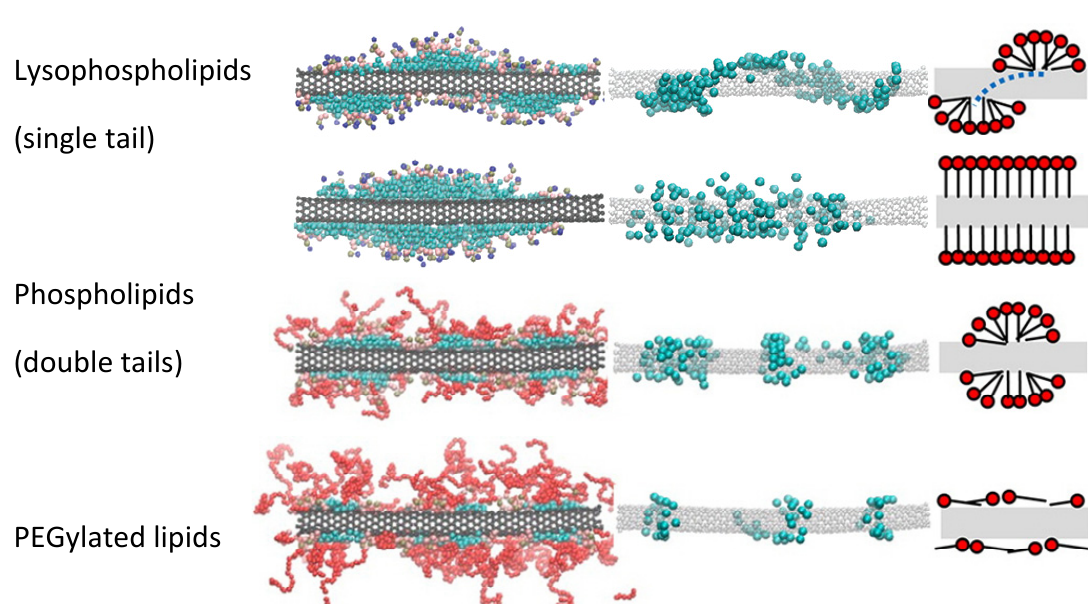
Figure 8. Snapshots at the end (500 ns) of simulations of single-walled carbon nanotubes (SWNTs) adsorbed onto lysophospholipids (1st row), phospholipids (2nd row), and PEGylated phospholipids (3rd and 4th rows). A cross section of the lipid-SWNT complex (left image) and a whole section of the SWNT with the ending (the last carbon). Coarse-grained (CG) beads of the lipid tail are depicted. Black, blue, and red colors respectively represent SWNTs, lipid tails, and PEG chains. (Reprinted with permission from [169]. Copyright 2013 American Chemical Society).